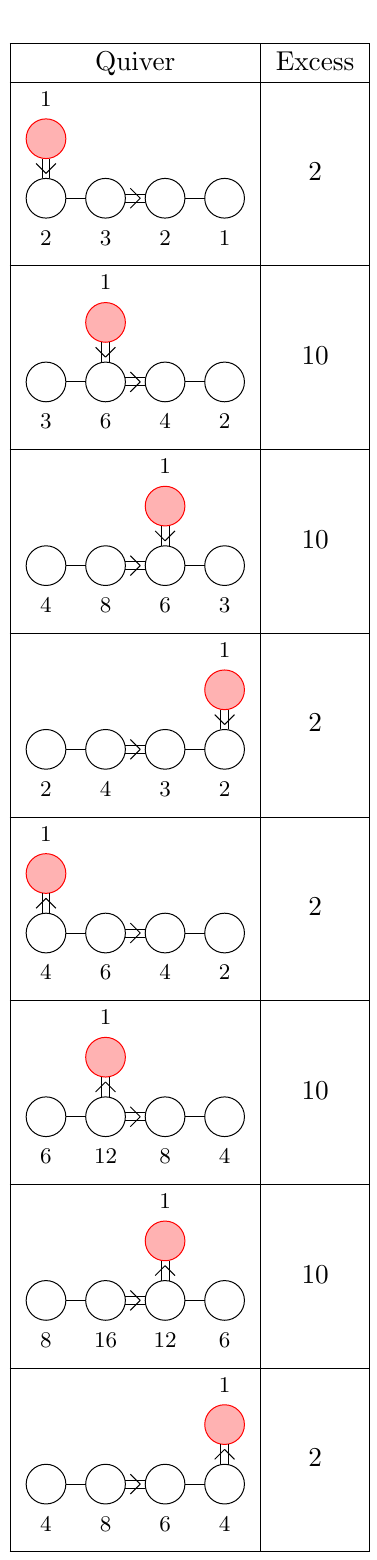
Table 32 . Exotic minimally unbalanced quivers with G = F 4 and an extra double laced